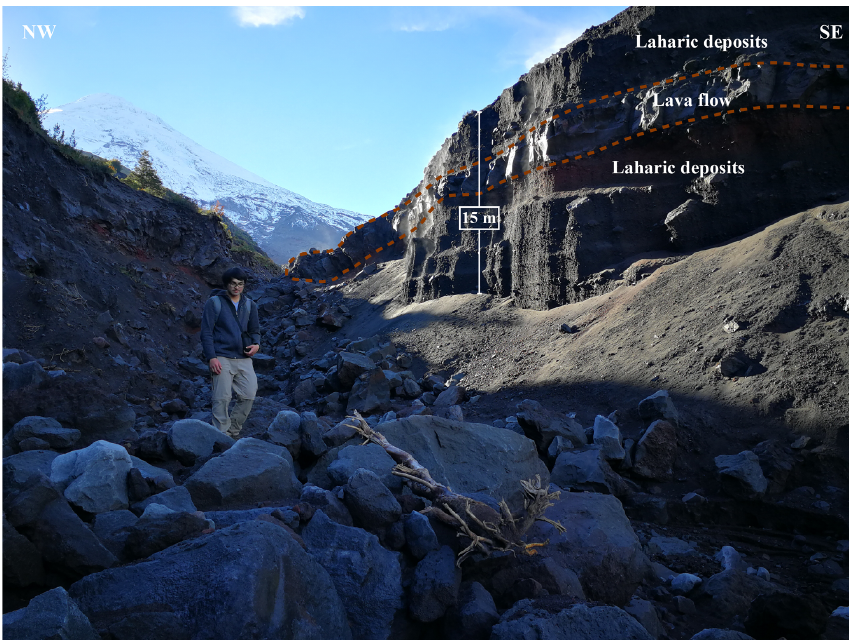
Figure 4. Set of scarps at approximately 1500ma.s.l.; the base breccia of the lava flows is heavily